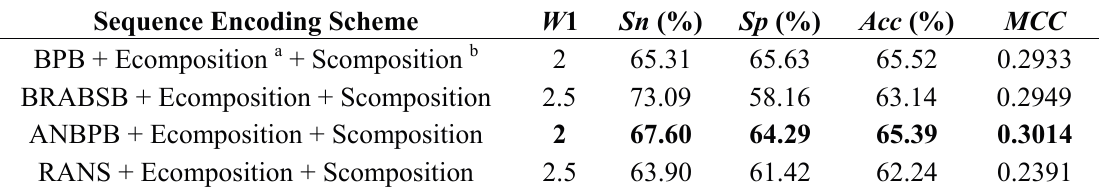
Table 1. Best predictive performances of four sequence encoding